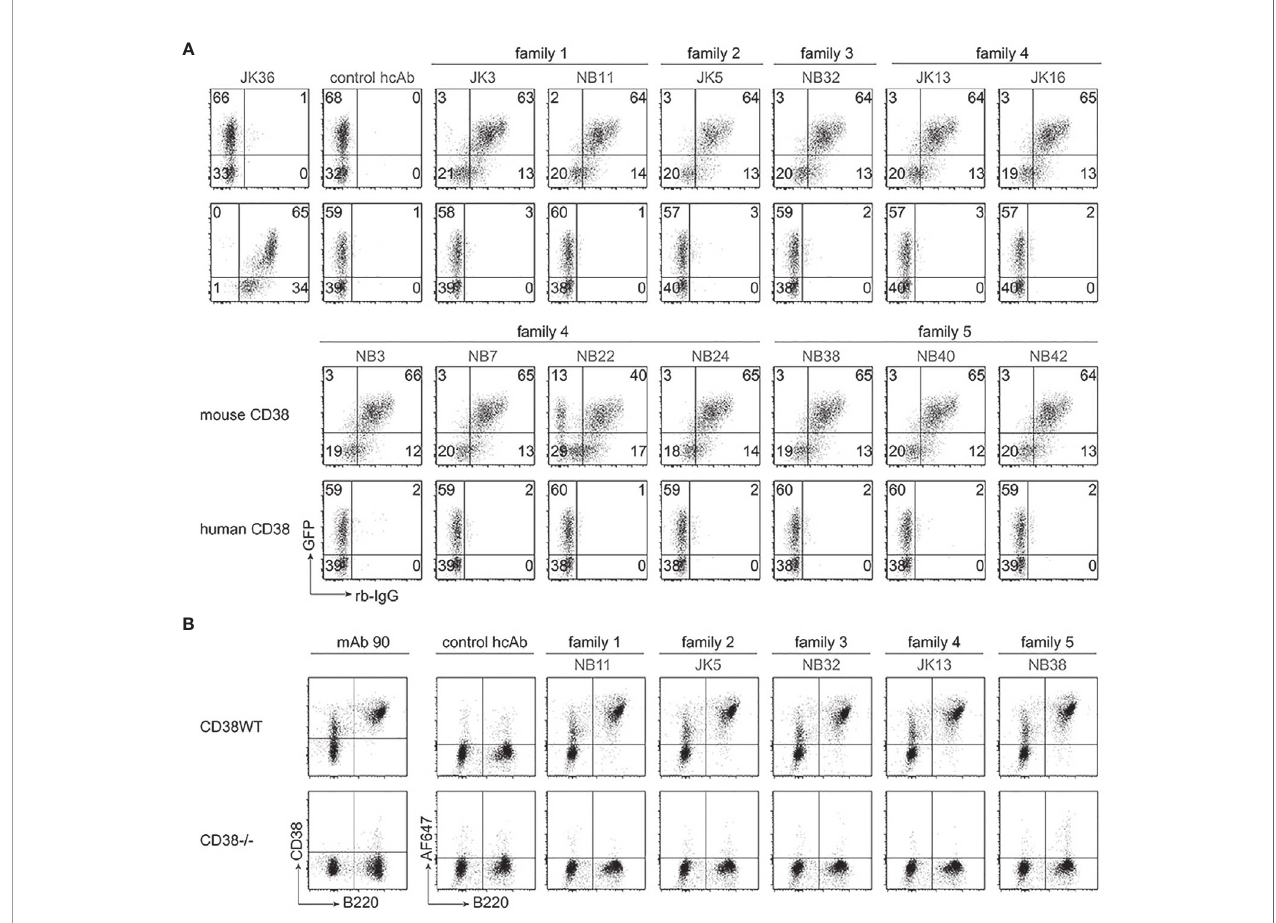
FIGURE 1 | Selected heavy chain antibodies speci fi cally recognize mouse CD38. (A) HEK cells were transiently co-transfected with expression constructs for GFP and either mouse CD38 (top rows) or human CD38 (bottom rows). Twenty-four hours after transfection, cells were incubated sequentially with selected nanobody- rabbit IgG hcAbs and APC-conjugated anti-rabbit IgG. Control stainings were performed with an isotype control hcAb and with human CD38-speci fi c JK36-hcAb. Numbers indicate the percentage of cells in the respective quadrants. Data are representative of two independent experiments. (B) Splenocytes from wildtype (WT) and Cd38 -/- mice were incubated with Alexa Fluor 647 -conjugated hcAbs, a FITC-conjugated B220-speci fi c mAb, and Alexa Fluor 750 as vitality dye. Control stainings were performed with an isotype control hcAb and a conventional mouse CD38-speci fi c mAb (clone 90). Gating was performed on live (Alexa Fluor 750-low) cells. Data are representative of two independent